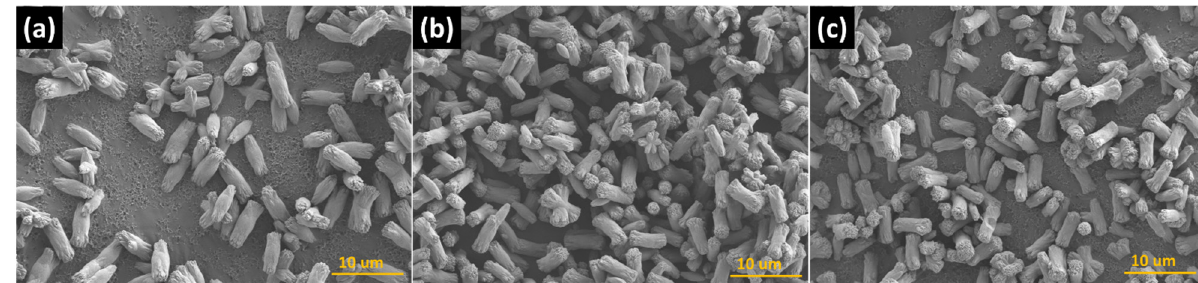
Figure 4. FE-SEM images of ( a ) SrWO 4 , ( b ) SrWO 4 :Dy 3+ , and ( c ) SrWO 4 :Sm 3+ powders.